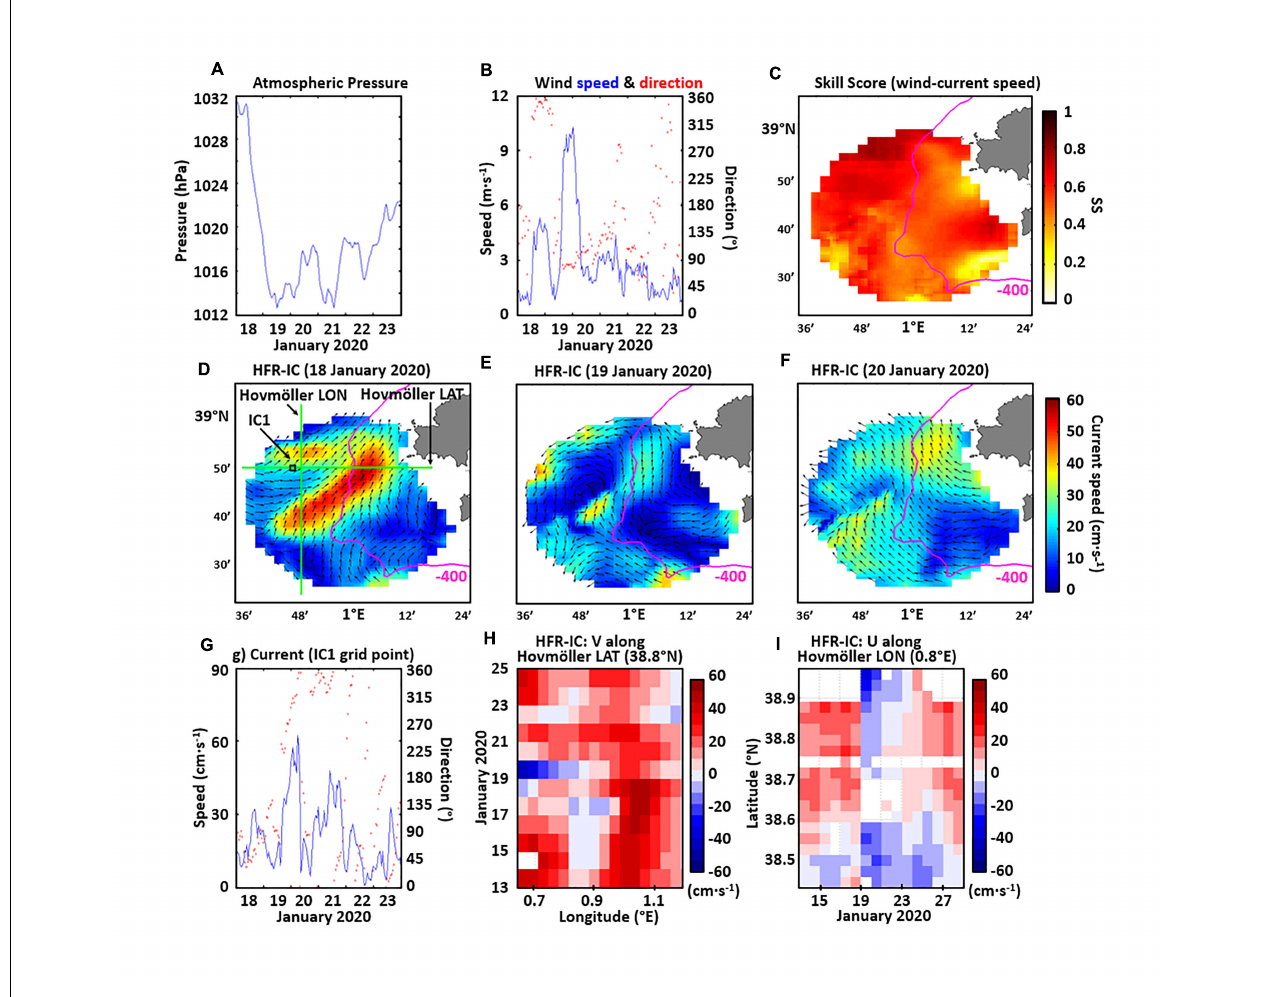
FIGURE 11 | Six-day time series of hourly SLP (A) , wind speed (blue line) and direction (red dots) at 25 m height (B) registered by an Autonomous Weather Station (Wsta in Figure 1A ); (C) Map of Skill Score (SS) between hourly wind speed registered at Wsta and current speed estimated by HFR-IC, for a 6-day period from January 18–23. Daily surface circulation maps as derived from HFR-IC current estimations before (D) , during (E) , and after (F) storm Gloria passage. Green lines indicate the latitudinal and longitudinal transects selected to compute Hovmöller diagrams. The location of IC1 grid point (coincident with the Ibiza Channel buoy, out of order during storm Gloria) is denoted by a black square; (G) 6-day time series of hourly surface current speed (blue line) and direction (red dots) at IC1 grid point ( ◦ N, ◦ E); (H) Hovmöller diagram of HFR-derived meridional (V) currents along the selected transect at 38.8 ◦ N; (I) Hovmöller diagram of HFR-derived zonal (U) currents along the selected transect at 0.8 ◦ E. Red (blue) colors indicate northward (southward) and eastward (westward) currents in panels (H) and (I) ,